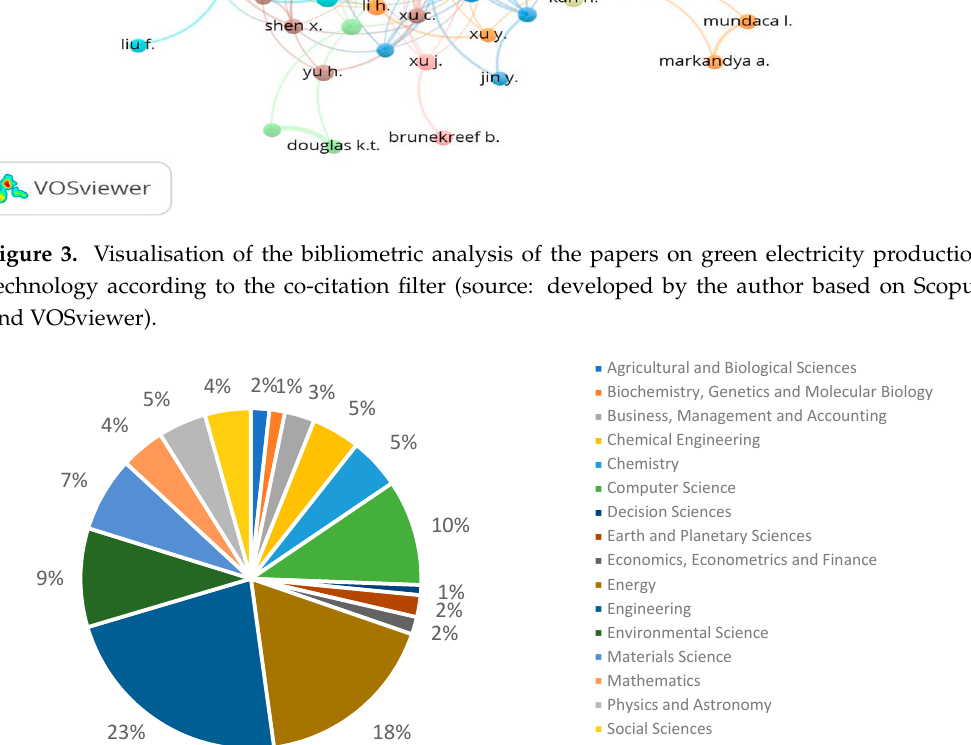
Figure 3. Visualisation of the bibliometric analysis of the papers on green electricity production technology according to the co-citation filter (source: developed by the author based on Scopus and VOSviewer).